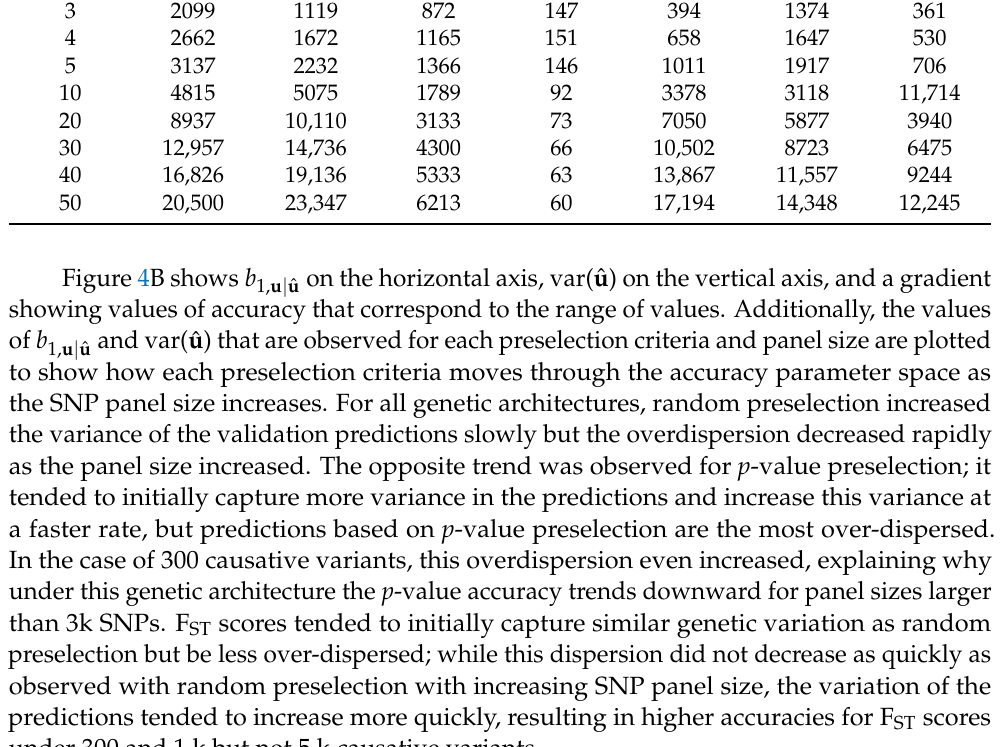
Selected by All